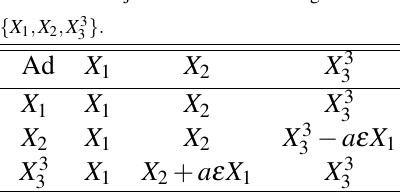
Table 6: Adjoint table for the Lie algebra { X 1 , X 2 , X 3 } 3